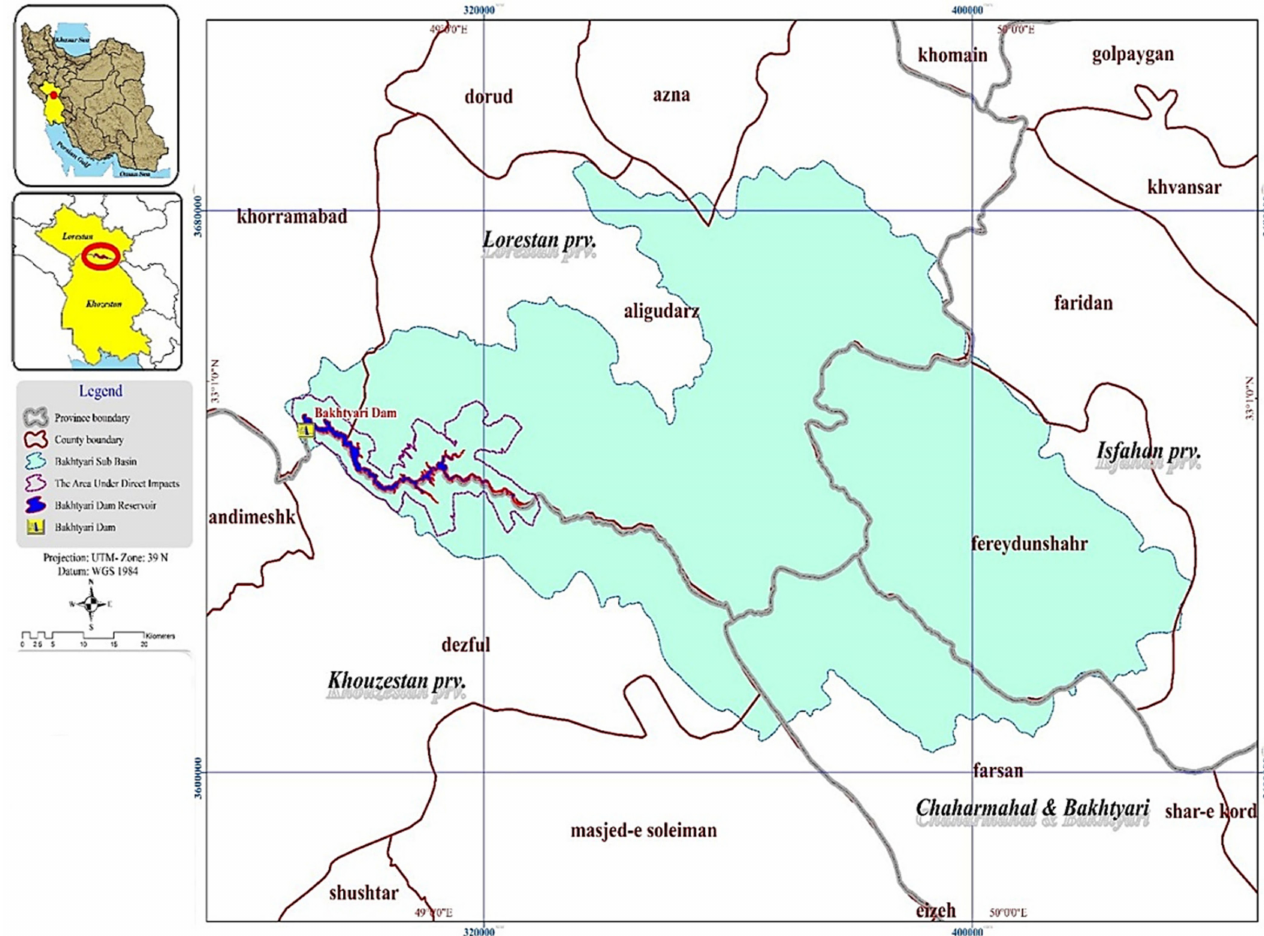
Figure 1. An aerial view of the area of study showing border